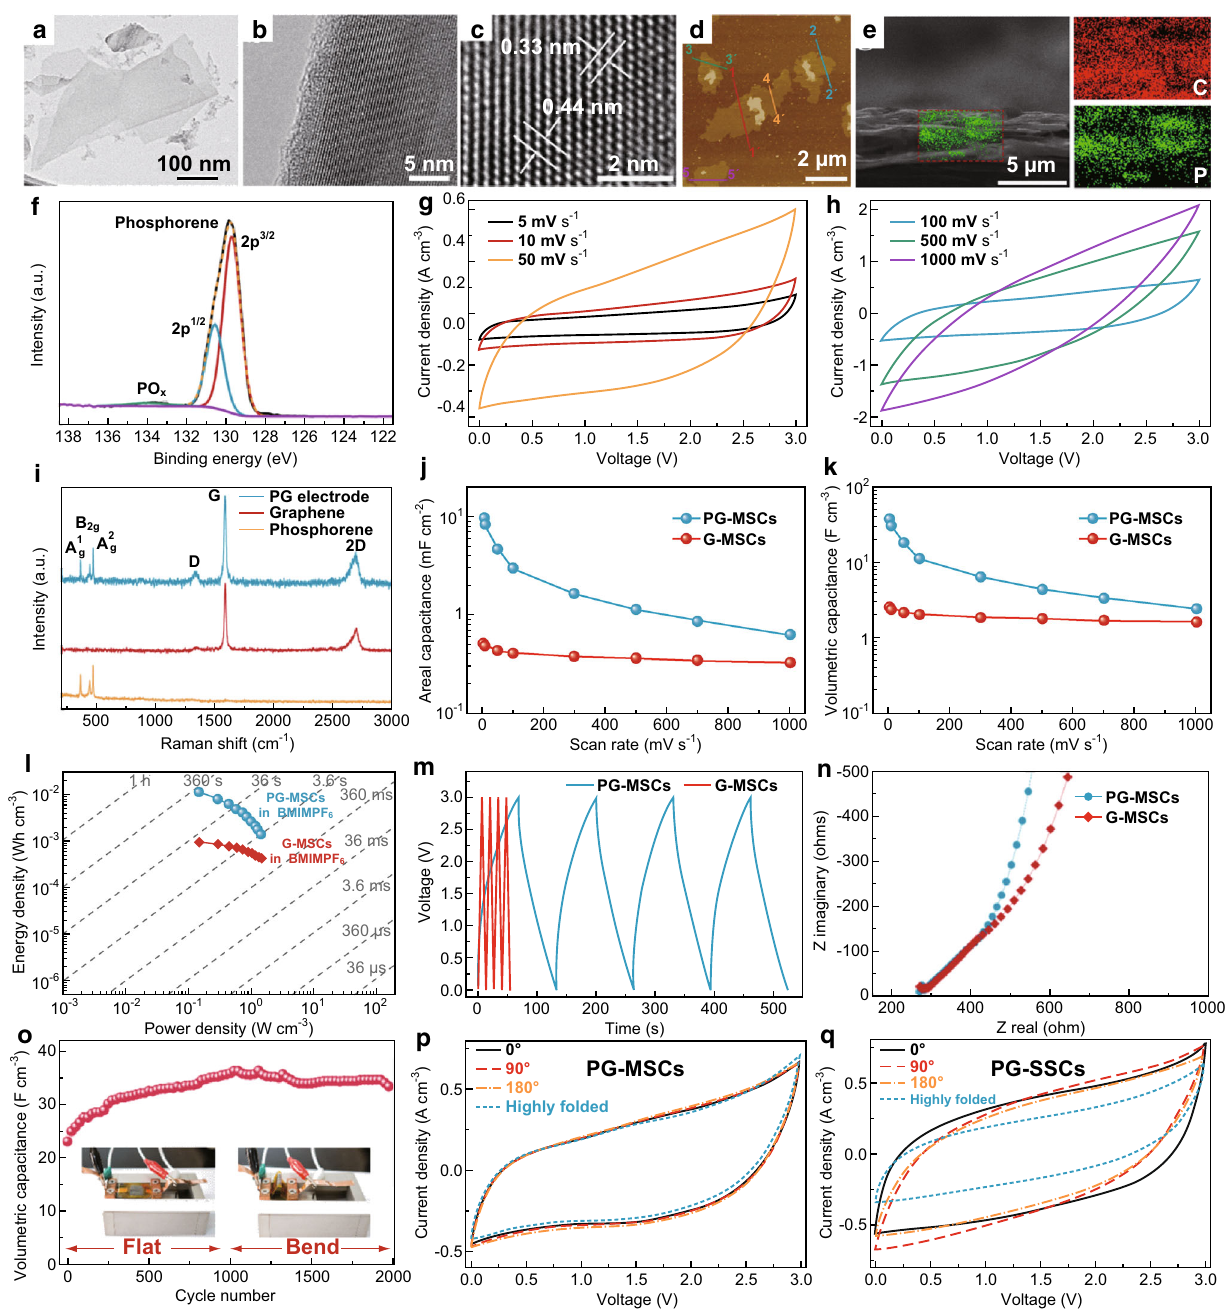
Fig. 10 Structural characterization and electrochemical performance analysis of phosphorene as a supercapacitor electrode: a TEM image of phosphorene thin film b HRTEM image of the phosphorene thin film. c HRTEM micrograph of the phosphorene thin film with atomic positions and lattice parameters. d AFM image of the phosphorene thin film. e SEM image of the cross section of the phosphorene thin film with EDX spectra of the selected region. f XPS spectra of phosphorene thin film. g , h CV at varying scan rates of P/G anode and G anode, respectively. i XRD spectra stack of the phosphorene (orange), graphene (red) ,and P/G composite electrode (blue). j Aerial capacitances of P/G (blue) and G (red) samples. k Volumetric capacitances of P/G (blue) and G (red) samples. l Ragone plots of P/G (blue) and G (red) samples. m GCD curves of the P/G (blue) and G (red) samples at a current density of 0.3 A cm - 3 . n Complex part of the impedance spectra of P/G (blue) and the G (red) samples. o Stability performance of the P/G sample over 2000 cycles with the inset pictures showing the flat and bending orientations. p CV curves of the P/G composite micro-supercapacitor. q CV curves of the P/G composite on PET substrate [174]. Copyright 2017 American Chemical Society. (Color figure